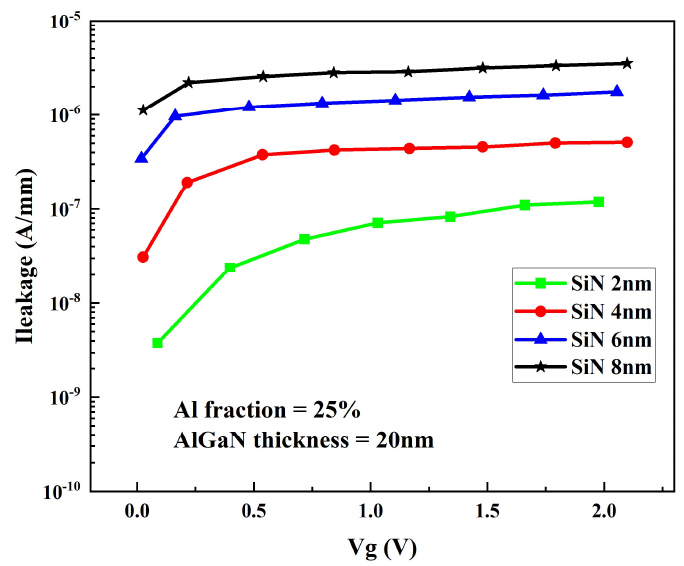
Figure 10. Variation curve of grid leakage current density with passivation layer thickness.